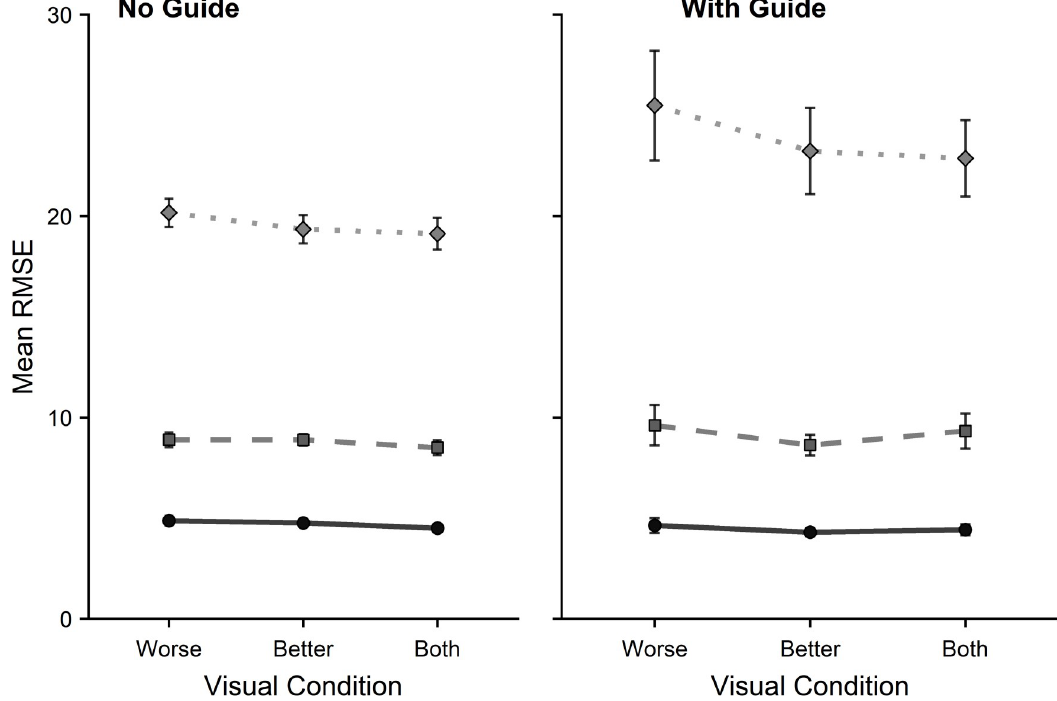
Fig 7. Tracking a moving target in a ‘figure-of-8’ trajectory with No Guide (NG) or With Guide (WG). Performance was measured using the mean root mean square error (RMSE) for all three speeds (Slow = circles, Medium = squares, Fast = diamonds) across all visual conditions (worse eye, better eye, both eyes). Note that the WG conditions were completed second so worse (and more variable) performance may reflect participant mental fatigue/boredom. Error bars represent the standard error of the mean. Where no error bars appear they are smaller than the size of the